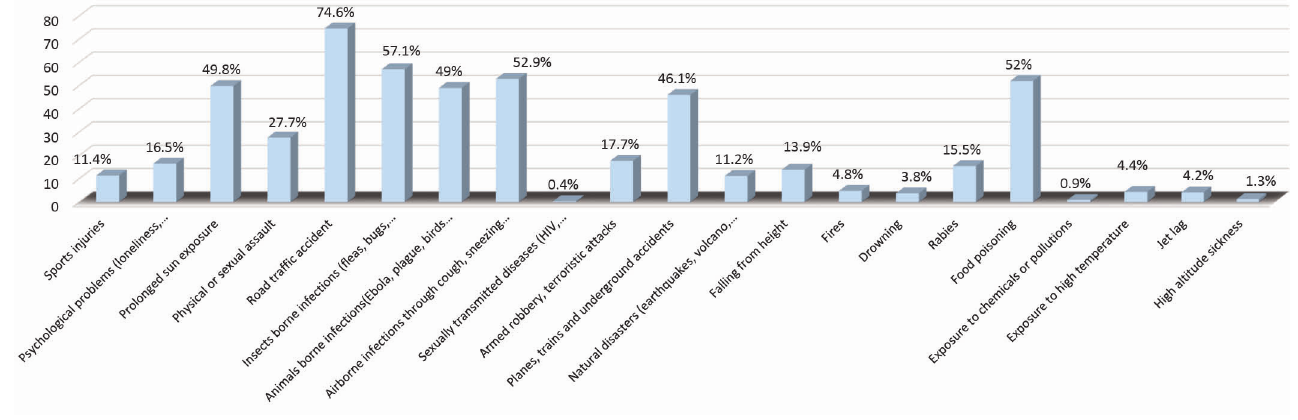
Figure 1. Types of Risks at Destination for Travelers Who Perceived any Travel Health-Related Risks.